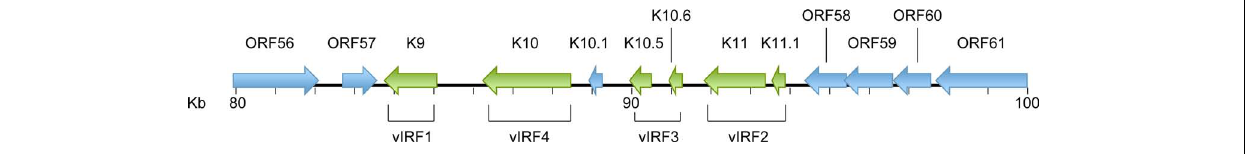
FIGURE 2 | Map of vIRF gene locus in the KSHV genome. The KSHV vIRF genes are encoded by open reading frames K9 (vIRF1), K11 and K11.1 (vIRF2), K10.5 and 10.6 (vIRF3), and K10 (vIRF4).